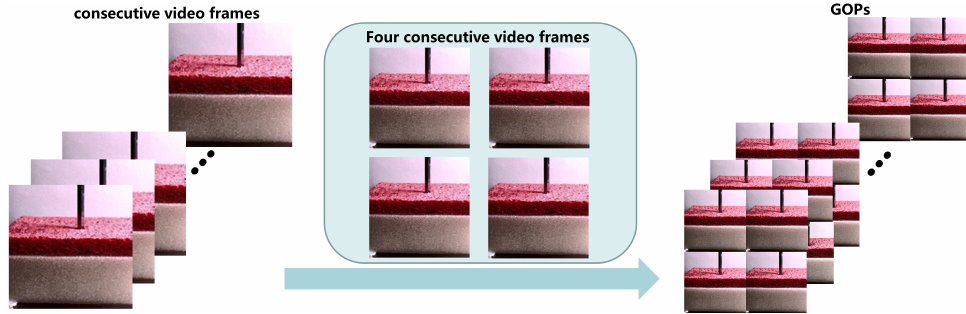
Figure 2. Preprocessing of video frames.